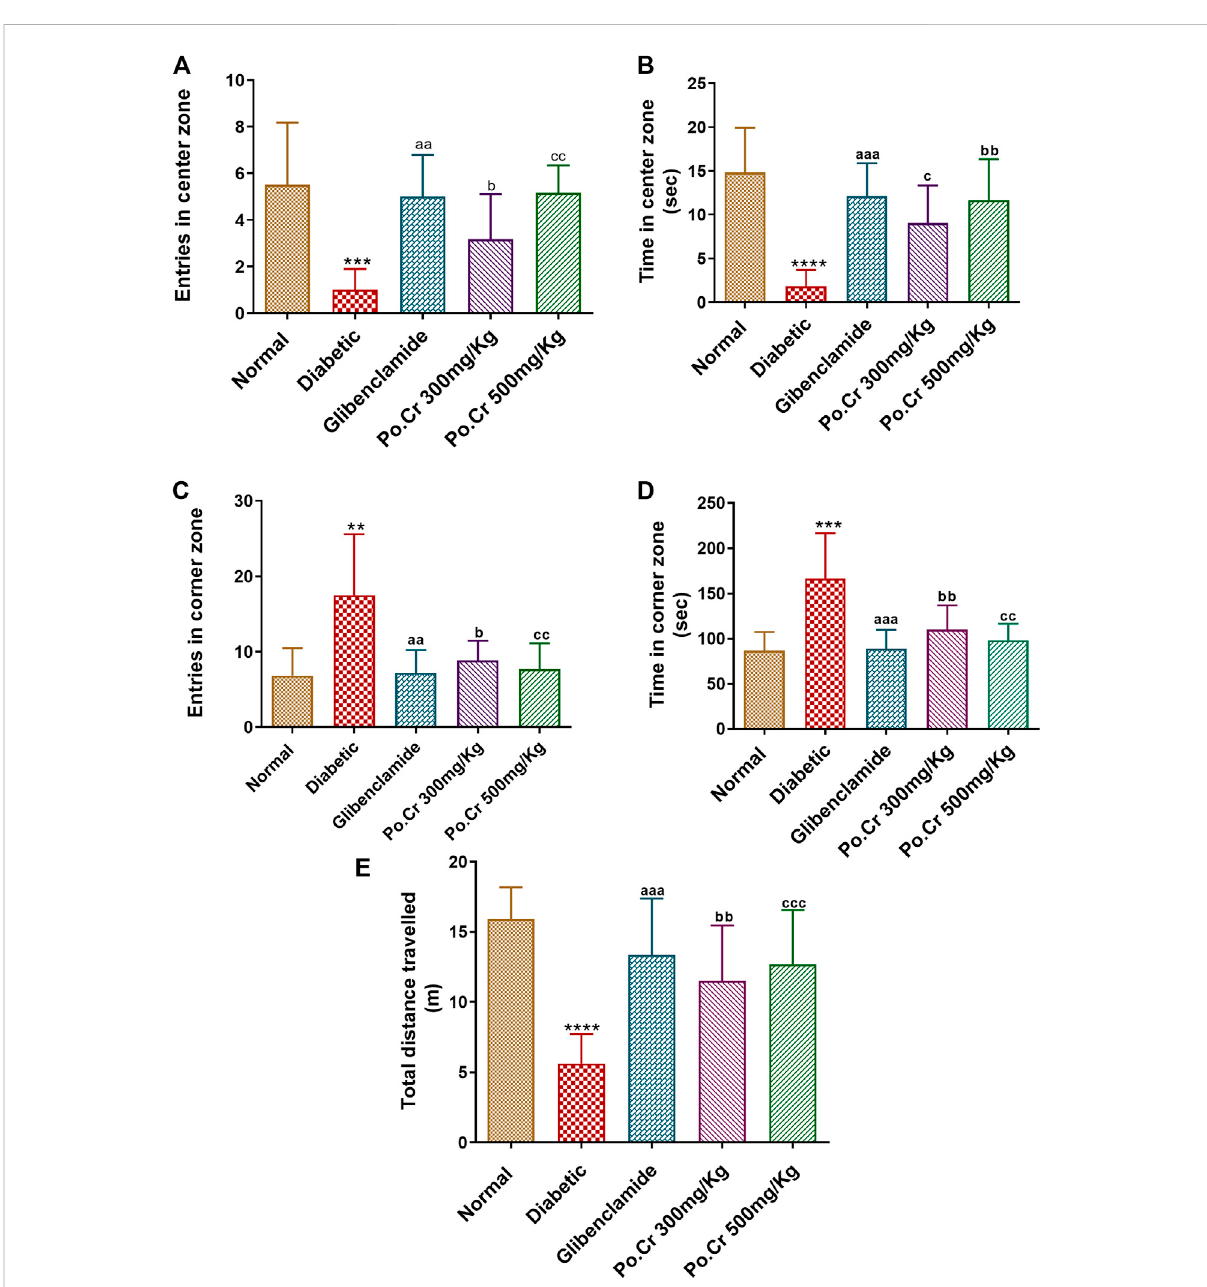
FIGURE 3 Anxiolytic capacity of aqueous extract of Plumeria obtusa at doses of 300 and 500 mg/kg assessed using the open fi eld test. (A) Entries into center zone. (B) Time spent incenter zone. (C) Entries into corner zone. (D) Time spent incornerzone. (E) Total distancetravelled. Group II (diabetic control) was compared to Group I (normal control), whereas all the treated groups (Groups III [glibenclamide] to V [Po.Cr]) were compared with Group II (diabetic control). ANOVA (two-way) and the multiple comparison Dunnett ’ s test were applied, and the data values are mean ±